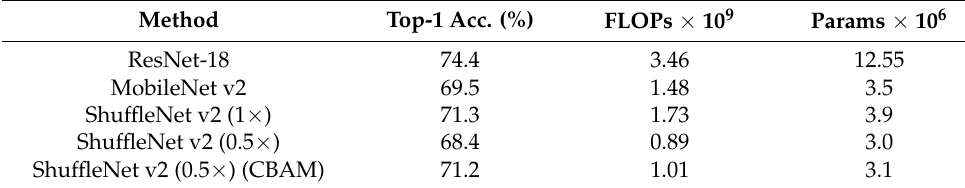
Table 3. Performance of different models. The number of channels is scaled for different capacities, marked as 0.5 × , 1 × , and 2 × . Channel widths are the standard ones for ShuffleNet V2, while the base channel width for TCN is 256 channels.